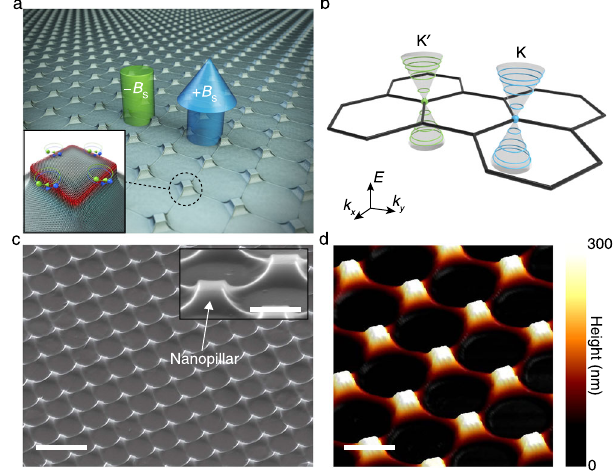
Fig. 1 Design of a strain-engineered graphene nanostructure array. a Schematic illustration of a strained graphene nanopillar array possessing pseudo-magnetic fi elds of positive ( + B S , blue arrow) and negative ( − B S , green arrow) signs. Inset: magni fi ed view of a single strained graphene nanopillar structure. Non-uniform tensile strain at the edges of the nanopillar induces pseudo-magnetic fi elds of opposite signs ( − B S and + B S ) in the two valleys of the graphene band structure, thus forcing electrons in the K and K ′ valleys to circulate in the opposite directions. b Schematic illustration showing Landau quantization at the K and K ′ points in the fi rst Brillouin zone of graphene in the presence of pseudo-magnetic fi elds. c Tilted-view SEM image of a strained graphene nanopillar array. Scale bar, 2 μ m. Inset: magni fi ed SEM image. Scale bar, 500 nm. d AFM topography of the strained graphene nanopillar array. Scale bar, 1 μ